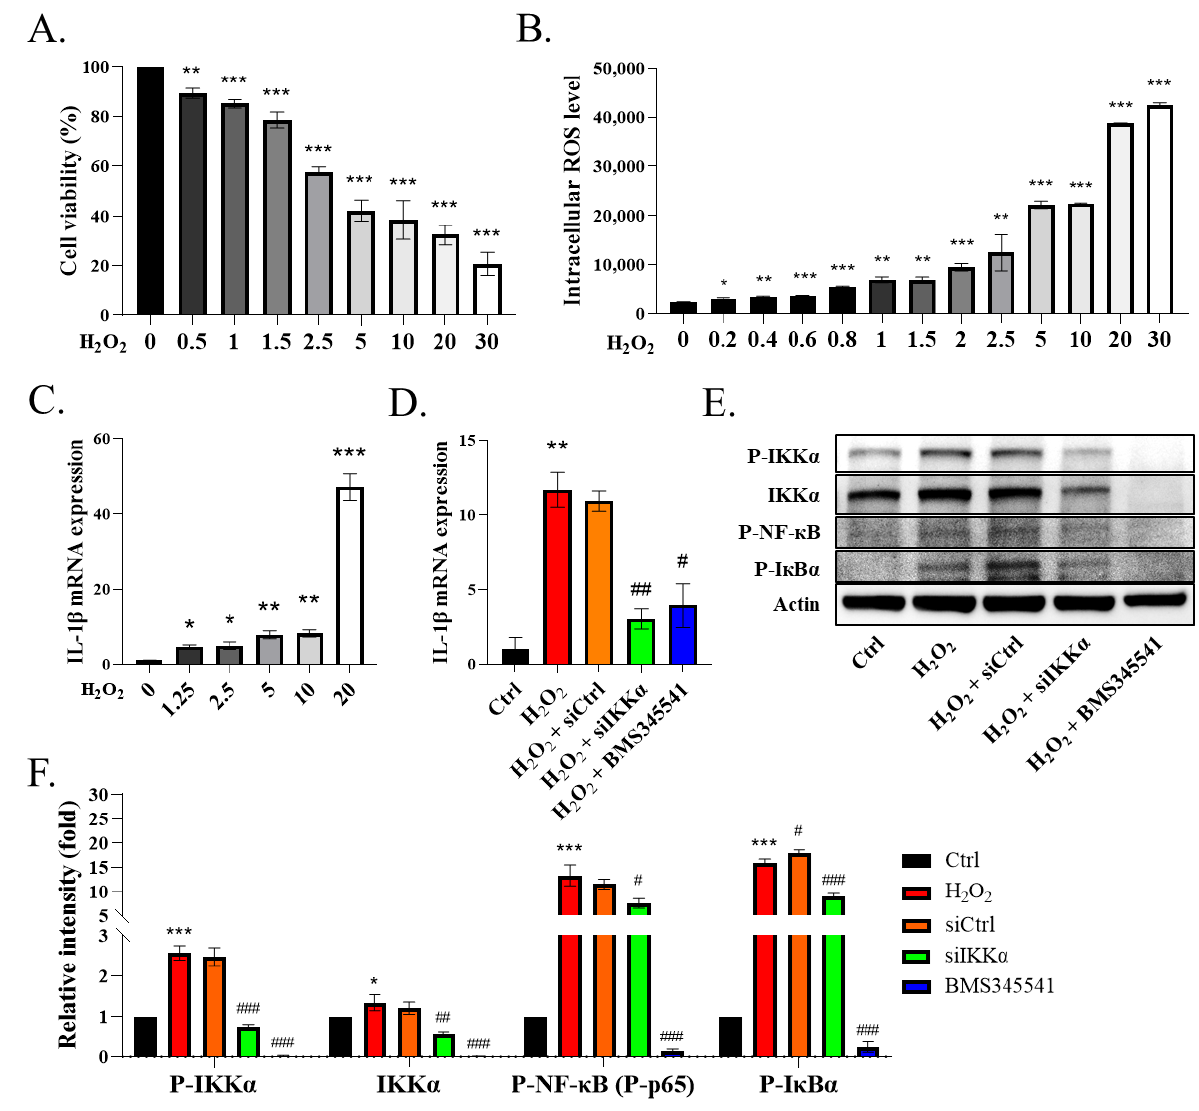
Figure 4. Knockdown of IKK α decreases NF- κ B/IL-1 β signaling in THP-1 cells. ( A ) Viability of H 2 O 2 (0–30 µ M)-treated THP-1 cells based on the WST-1 assay. ( B ) Levels of ROS measured by DCFH-DA staining. ( C ) mRNA levels of IL-1 β in H 2 O 2 (0–20 µ M)-treated THP-1 cells. ( D ) mRNA level of IL-1 β . THP-1 cells were transfected with siRNA-targeting IKK α (siIKK α ) or scrambled sequence (siCtrl) for 12 h. BMS-345541 was used to block IKK α / β . The cells were then stimulated (or